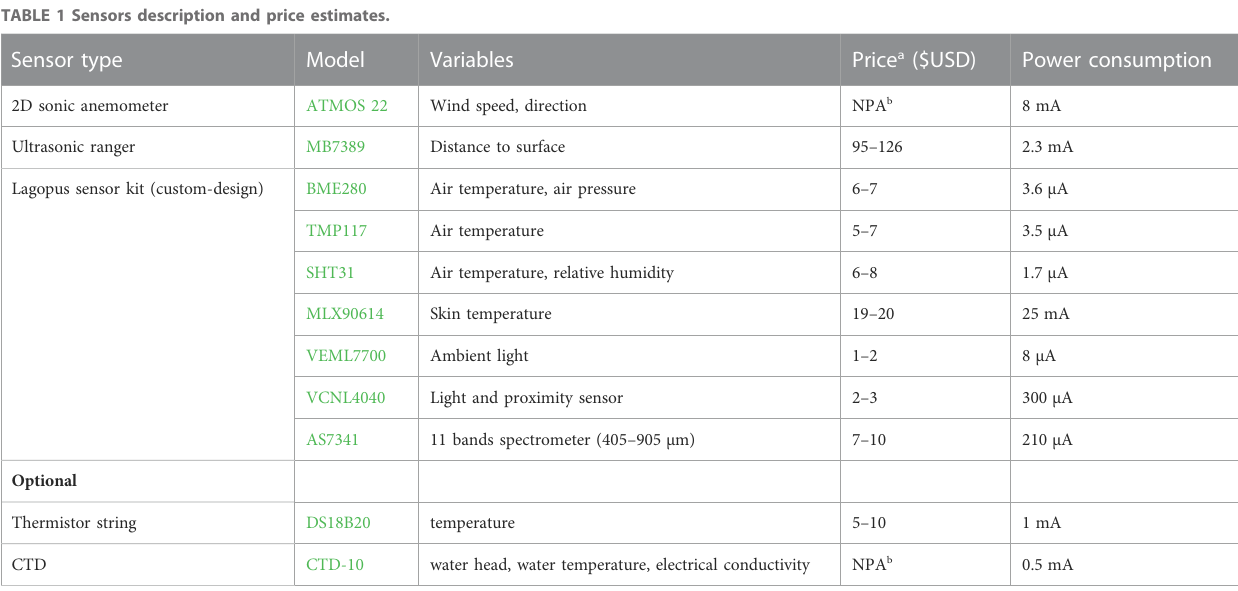
TABLE 1 Sensors description and price